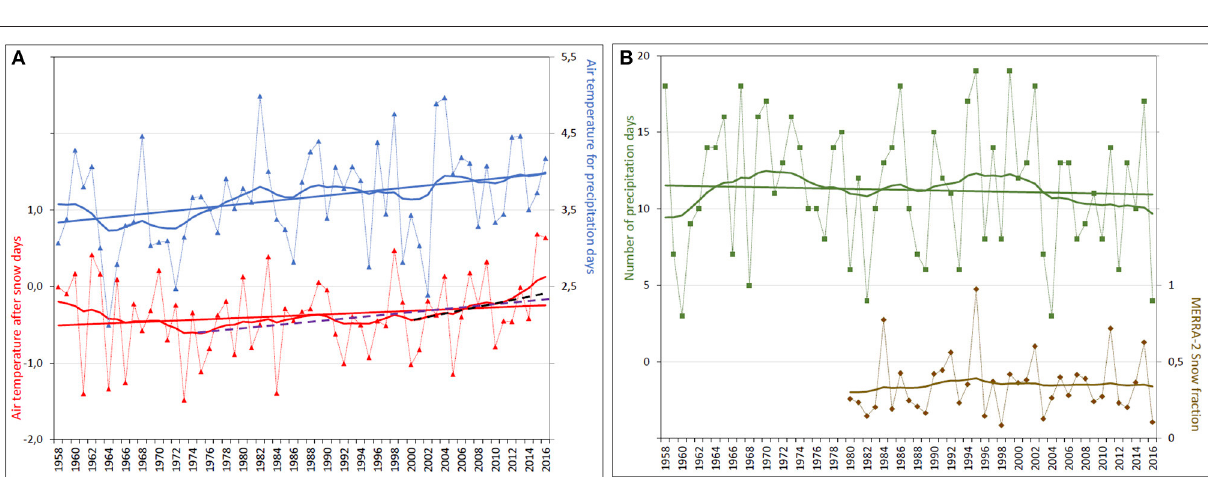
FIGURE 12 | Interannual variability, long-term behavior (after applying the exponential filter) and linear trend of: (A) mean air temperature for precipitation days (rain and snow) (blue, upper section) and for days after snow events (red, lower section). The dashed purple and black lines (lower section) are the linear trends for the 1973–2016 and 2000–2016 periods, respectively . (B) Number of precipitation days with air temperature < 2 ◦ C for each year (green, upper section). The brown curve (lower section) is the snow fraction obtained from the MERRA-2 simulation. All variables are expressed as annual data calculated for the extended winter April